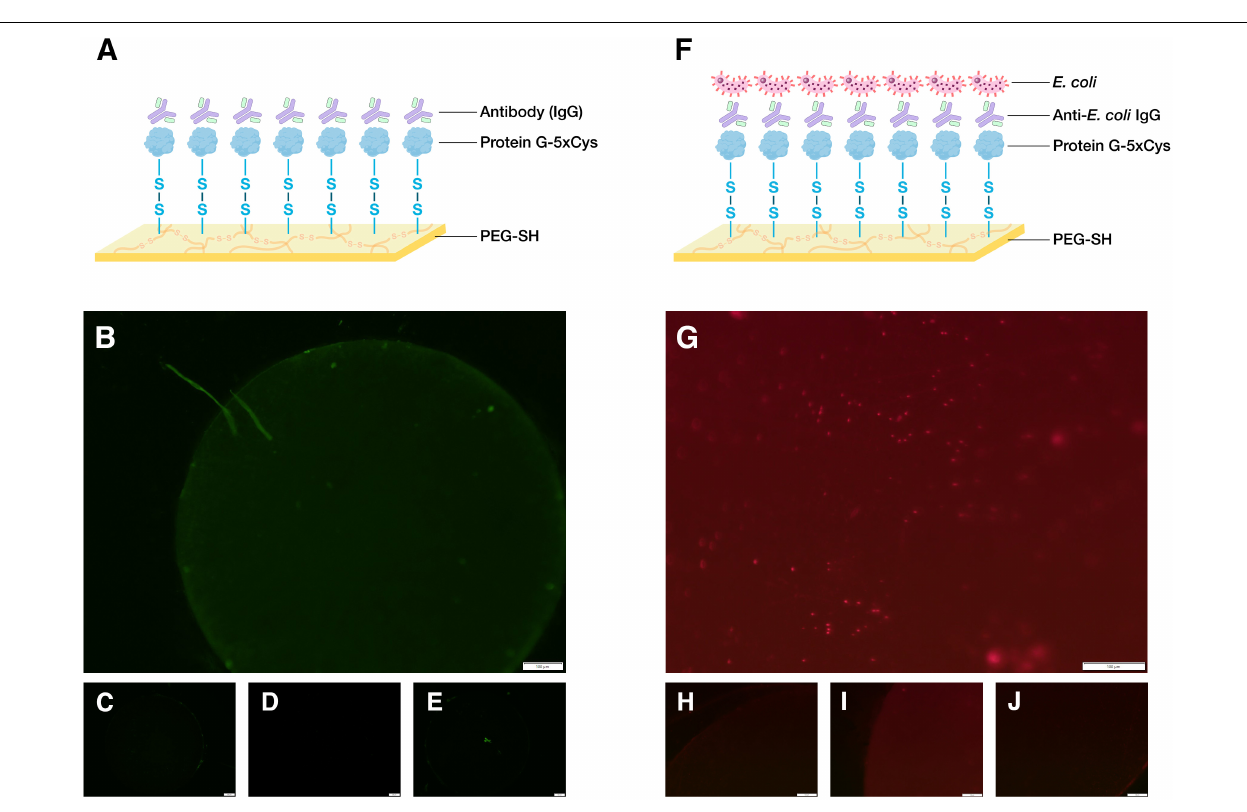
FIGURE 3 | Demonstration of biodevice assemblies. (A) Schematic of an antibody-binding platform, image created with BioRender.com. Here, 5xCys-tagged protein G is covalently grafted onto sulfenic acid groups on the surface of electroassembled thiolated polyethylene glycol (PEG-SH). The protein G binds the Fc region of IgG. (B) 1.6x microscope image of a working antibody-binding platform: PEG-SH coated standard gold electrode + protein G-5xCys + IgG:DyLight 488 (C–E) Control images: (C) standard gold electrode electrodeposited with PEG-SH hydrogel (D) PEG-SH coated electrode + protein G-5xCys. (E) PEG-SH coated electrode + IgG:DyLight 488 antibody. Exposure time = 200 ms. (F) Schematic of a cell-capture platform. Here, the IgG captured by the protein G in (A) presents anti- E. coli antigen binding domains to the solution containing E. coli , enabling cell capture. (G) 12.6x microscope image of a working cell-capture platform: PEG-SH coated standard gold electrode + protein G-5xCys + Anti- E. coli IgG + E. coli BL21 (DE3) with constitutive DsRed expression. (H–J) Control Images: (H) standard gold electrode electrodeposited with PEG-SH hydrogel (I) PEG-SH coated electrode + protein G-5xCys (J) PEG-SH coated electrode + Anti- E. coli IgG + E. coli BL21 (DE3) with constitutive DsRed expression. Exposure time = 650